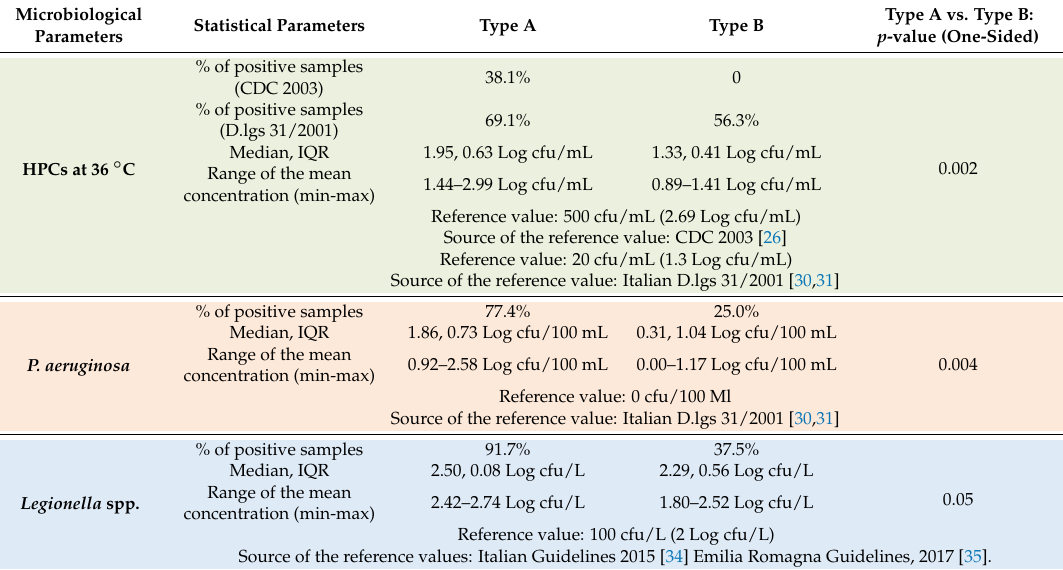
Table 2. Concentrations of microbiological contaminants in DUWL samples: Type A vs. Type